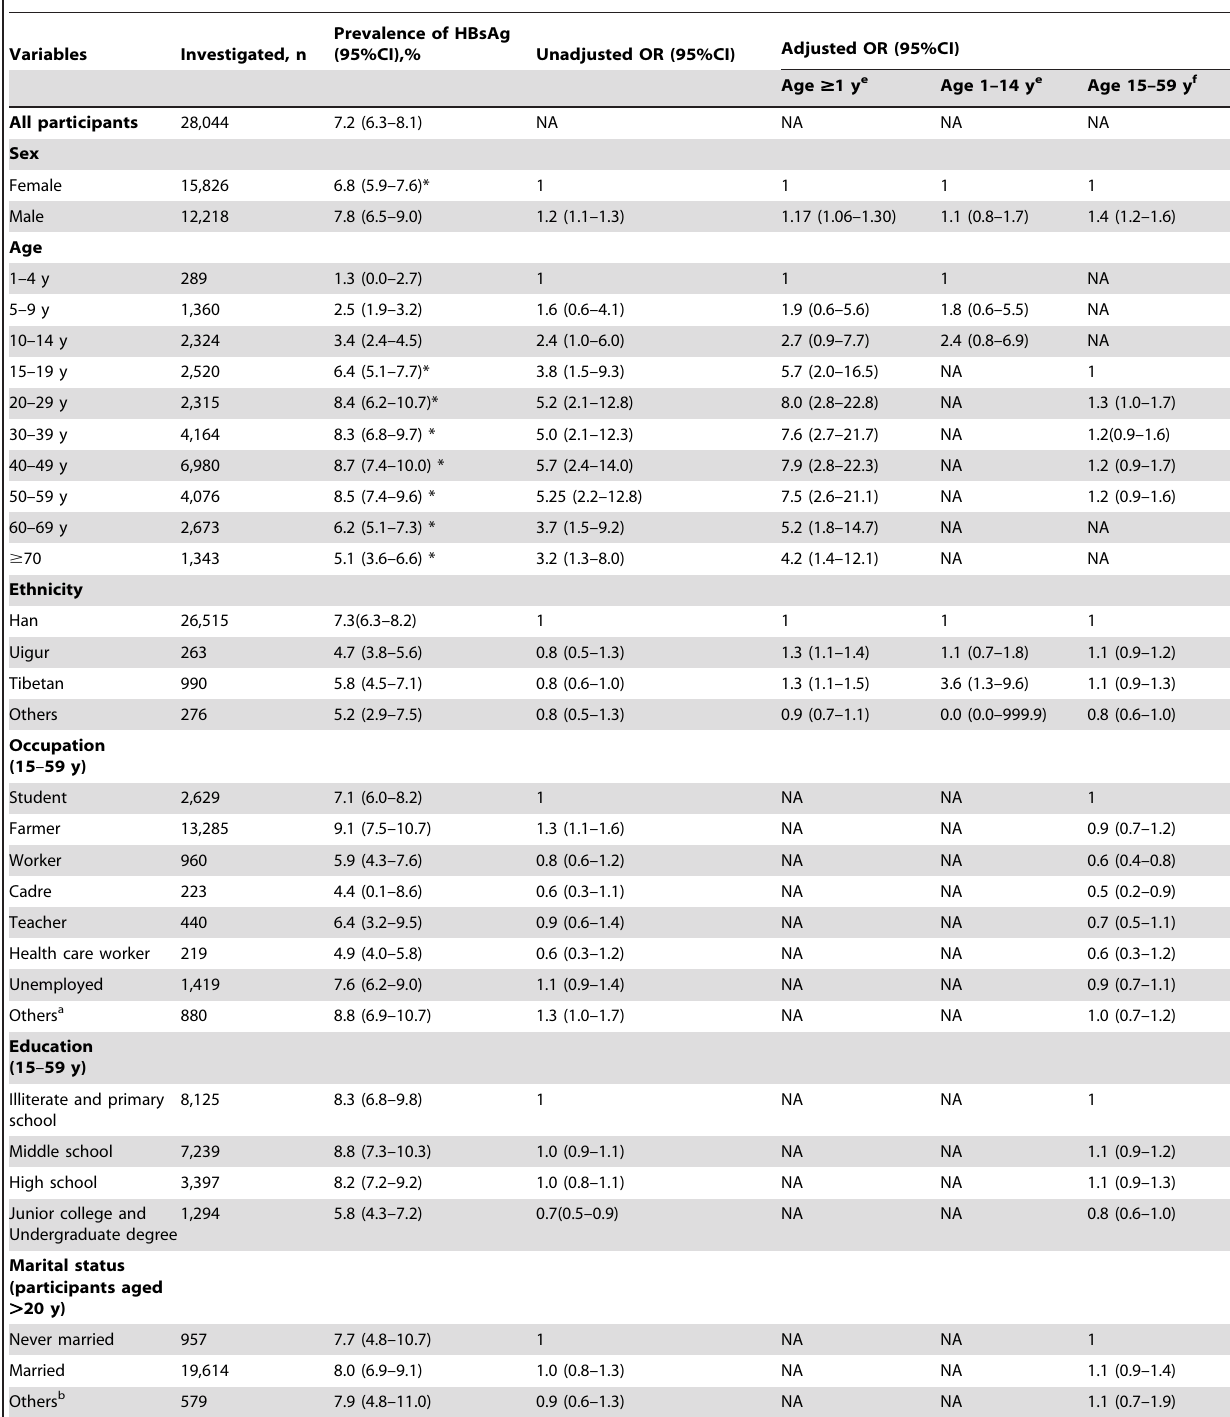
Table 1. Prevalence and Determinants of Chronic Hepatitis B Virus Infections (Positive HBsAg) Among Persons $ 1 Year of Age in Wuwei City,